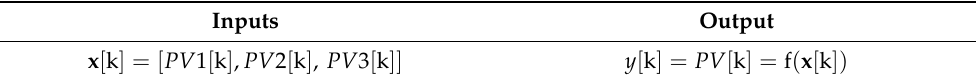
Table 6. Input–output pair of Experiment 3.